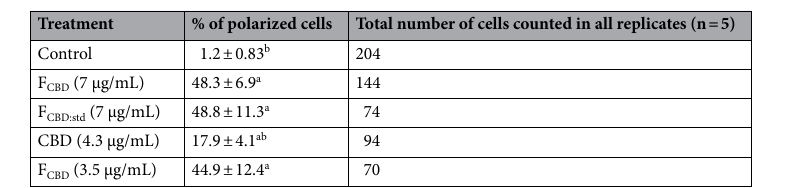
Table 2. Percentage of polarized cells out of the total differentiated KG1 cell population. Control (0.7% v/v methanol) treatment served as the solvent (vehicle) control. Means (n = 5 populations) labeled with different letters are significantly different from all combinations of pairs according to the Tukey–Kramer HSD test ( P ≤ 0.05).